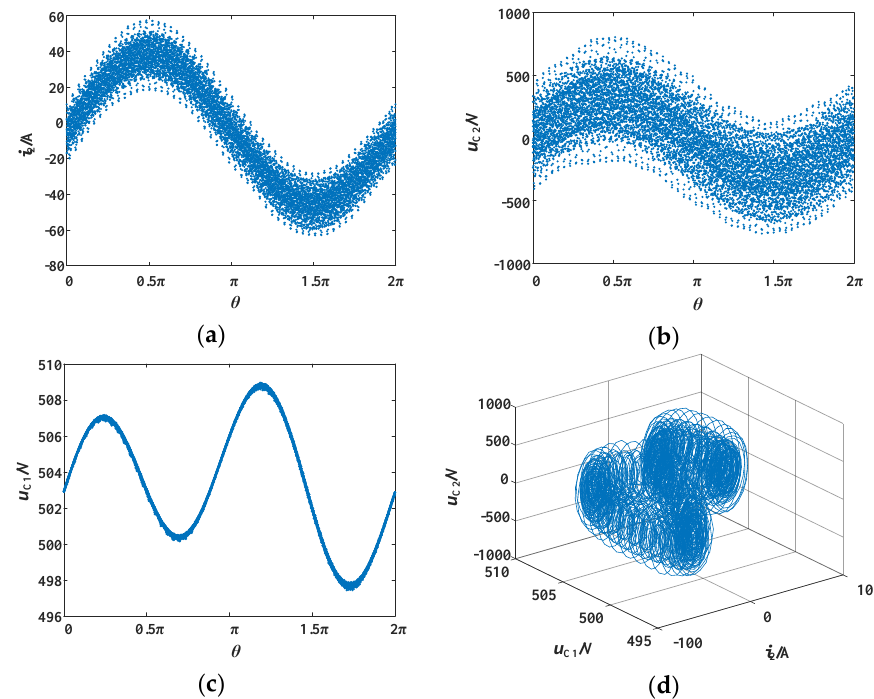
Figure 7. Chaotic motion at 𝜂 0 = 0.5 and 𝜂 1 = 0.5 . ( a ) Folded diagram of output current 𝑖 2 ; ( b ) Folded diagram of output voltage 𝑢 C2 ; ( c ) Folded diagram of output voltage 𝑢 C1 of the photovoltaic array; ( d ) Phase diagrams of chaotic motion of 𝑖 2 , 𝑢 C2 , and 𝑢 C1 .